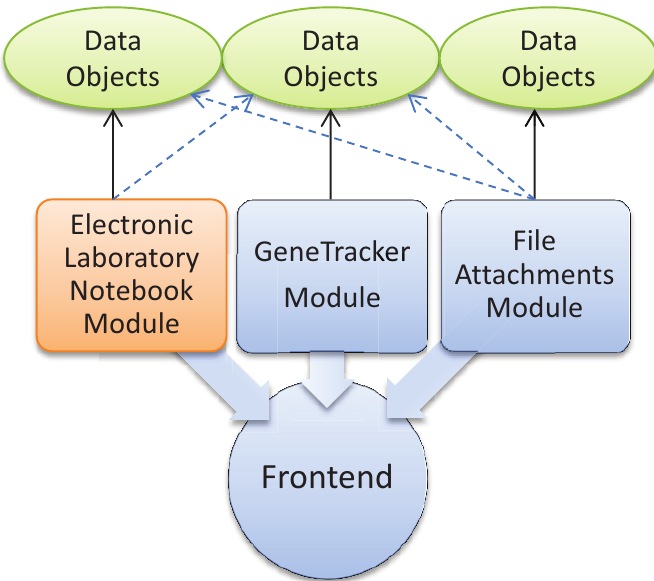
Figure 1: Integration of OpenLabNotes in OLF. To maintain its flexiblity, OLF keeps track of arbi- trary domain classes that extend a common class DataObject. This allows for complex interactions between modules. OpenLabNotes, for instance, generates DataObjects representing experimental notes and links them to other DataObjects, such as samples generated by OpenLabGeneTracker. The FileAttachment module can generate DataObjects encapsulating uploaded documents and links them to either DataObjects irrespective of whether they represent samples or ELN